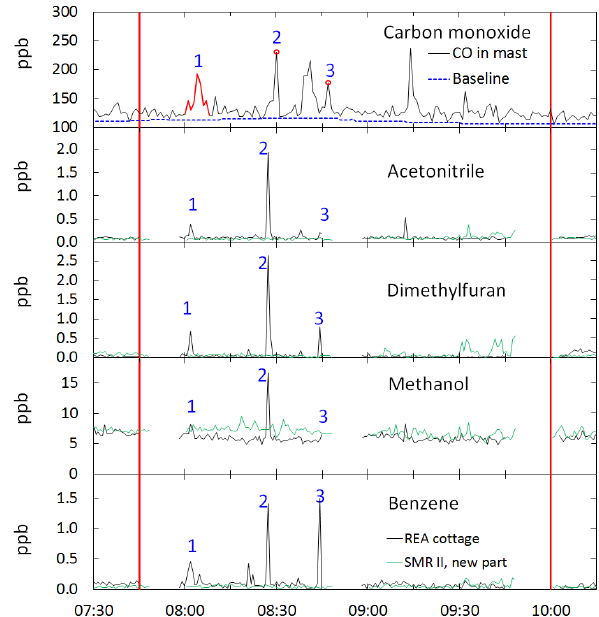
Fig. 7. Data of selected VOCs measured with PTR-MS at two lo- cations and carbon monoxide measured by the mast at all altitudes. The numbers on the peaks and the red line for CO in peak 1 denote the data that were used for the regressions in Fig. 8 and Table